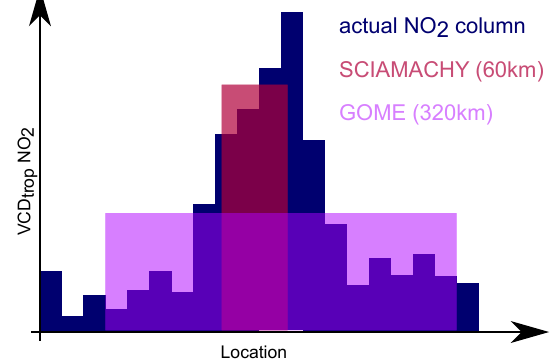
Fig. 1. Schematic view of the effect of the instrument’s ground pixel size on the measured VCD trop NO 2